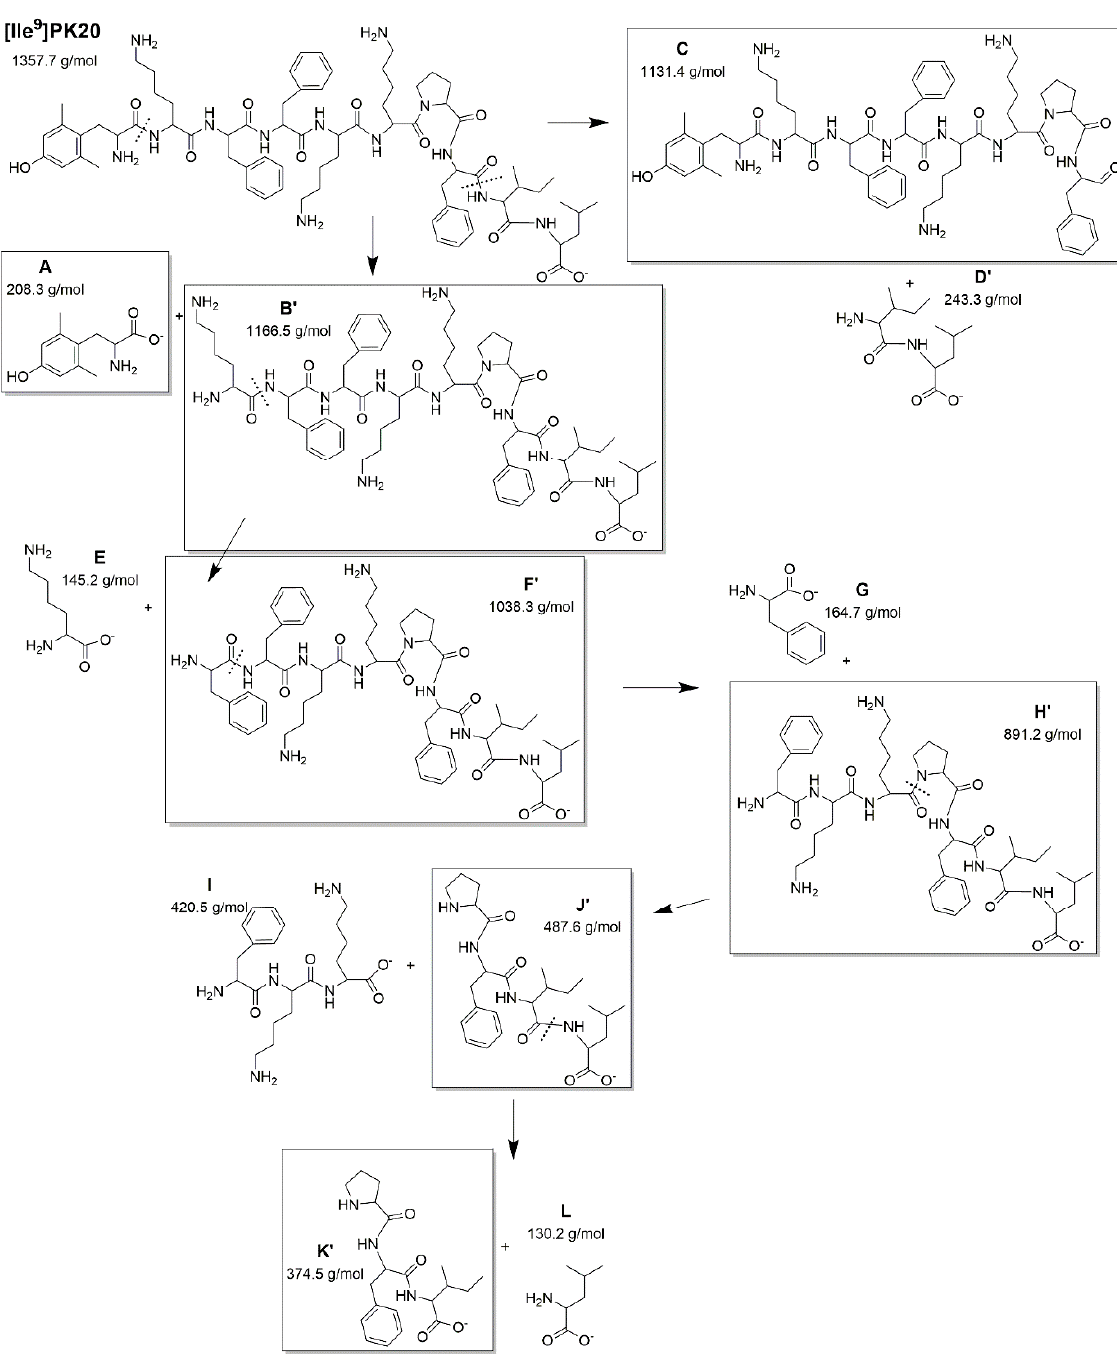
Figure 5. Representative structures of potential [Ile 9 ]PK20’s degradation products based on the mo- lecular weight obtained, and identified as: compound K’—Pro-Phe-Tle [m/z observed = 374.22 g/mol compound K’—Pro-Phe-Tle [m/z vs. MW calculated = 374.5 g/mol]; compound J’—Pro-Phe-Tle-Leu [m/z observed = 487.42 g/mol vs. observed = 374.22 g/mol vs. MW calculated = 374.5 g/mol]; compound J’—Pro-Phe-Tle-Leu [m/z MW calculated = 487.6 g/mol]; compound H’—Phe-Lys-Lys-Pro-Phe-Tle-Leu [m/z observed = 890.96 observed = 487.42 g/mol vs. MW calculated = 487.6 g/mol]; compound H’—Phe-Lys-Lys-Pro-Phe- g/mol vs. MW calculated = 891.2 g/mol] with [Ile 9 ]PK20 [m/z observed = 1357.45 g/mol vs. MW cal- Tle-Leu [m/z observed = 890.96 g/mol vs. MW calculated = 891.2 g/mol] with [Ile 9 ]PK20 [m/z culated = 1357.7 g/mol]. observed = 1357.45 g/mol vs. MW calculated = 1357.7